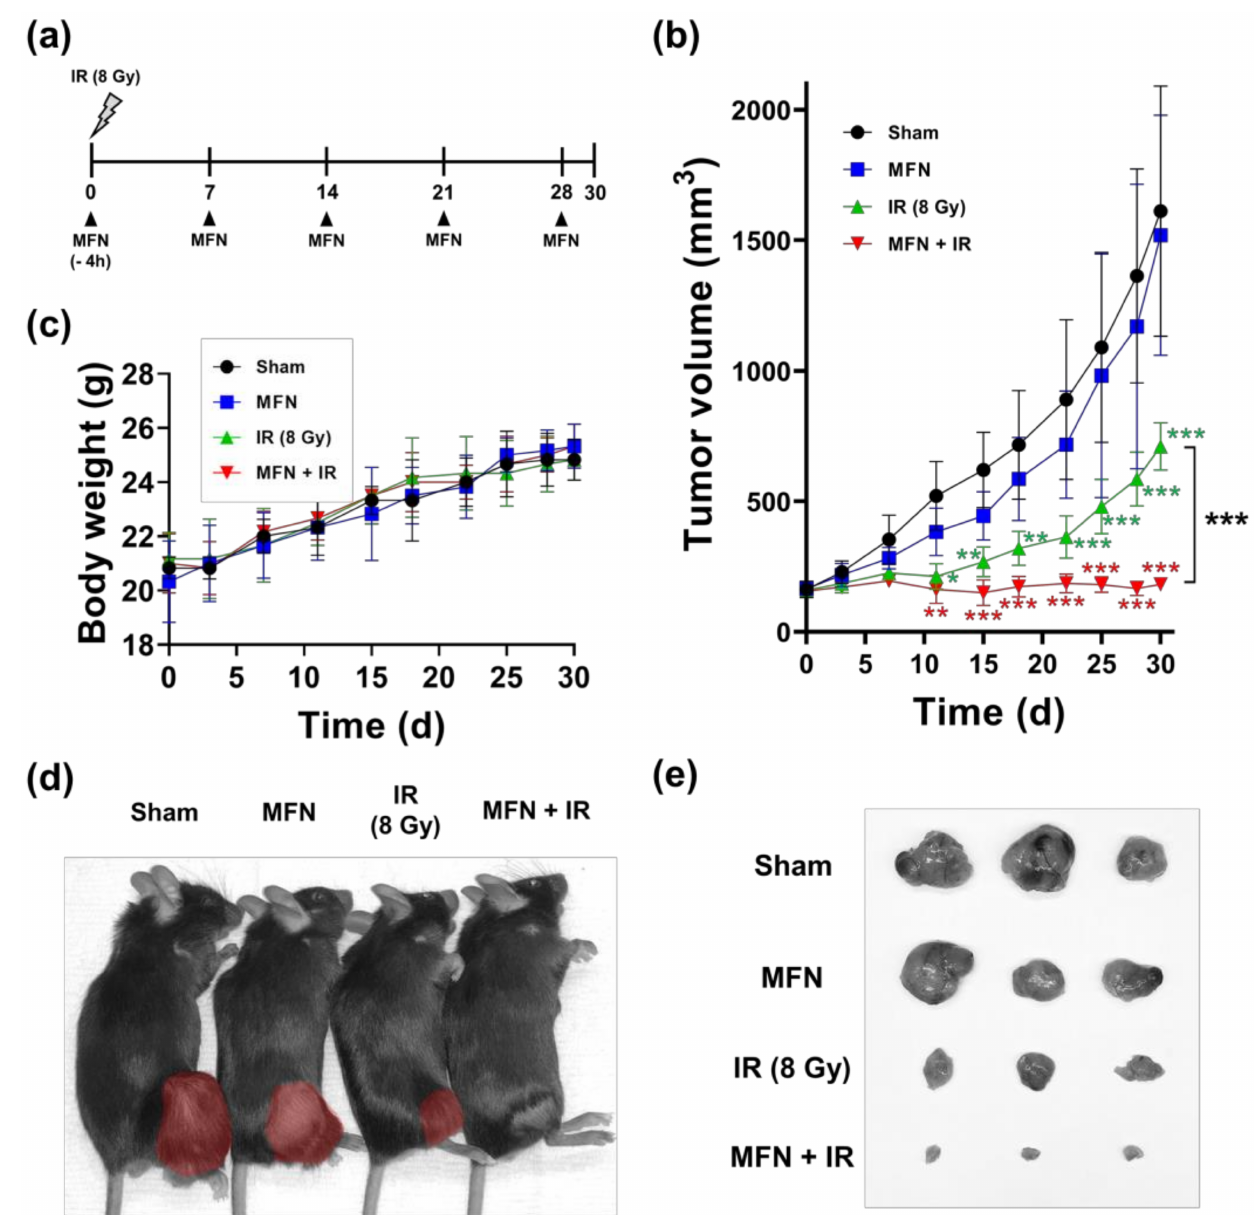
Figure 4. In vivo tumor radiosensitization by MnFe 2 O 4 nanoparticles (MFN) in a Hepa1-6 syngeneic mouse model. ( a ) Scheme of the experimental procedures carried out using the mouse model. One fraction of the 8-Gy radiation dose was administered at the right hind leg where Hepa1-6 cells were implanted, and/or the MFN were repeatedly injected intratumorally. ( b ) Growth patterns of tumors in terms of tumor volume. ( c ) Changes in the body weight of mice during the experiment. ( d ) Macroscopic features of mice and implanted tumors (brown) at the end of the experiment. ( e ) Sizes of tumor tissues collected after euthanizing the mice on day 30. The values represent the mean ± SD; * p < 0.05; ** p < 0.01; *** p < 0.001; two-way ANOVA ( n =